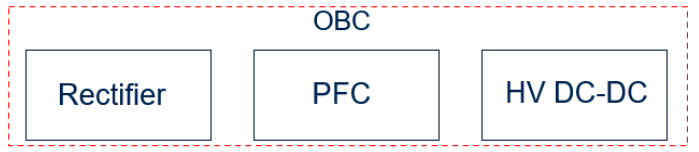
Figure 18. Block scheme of OBC architecture.